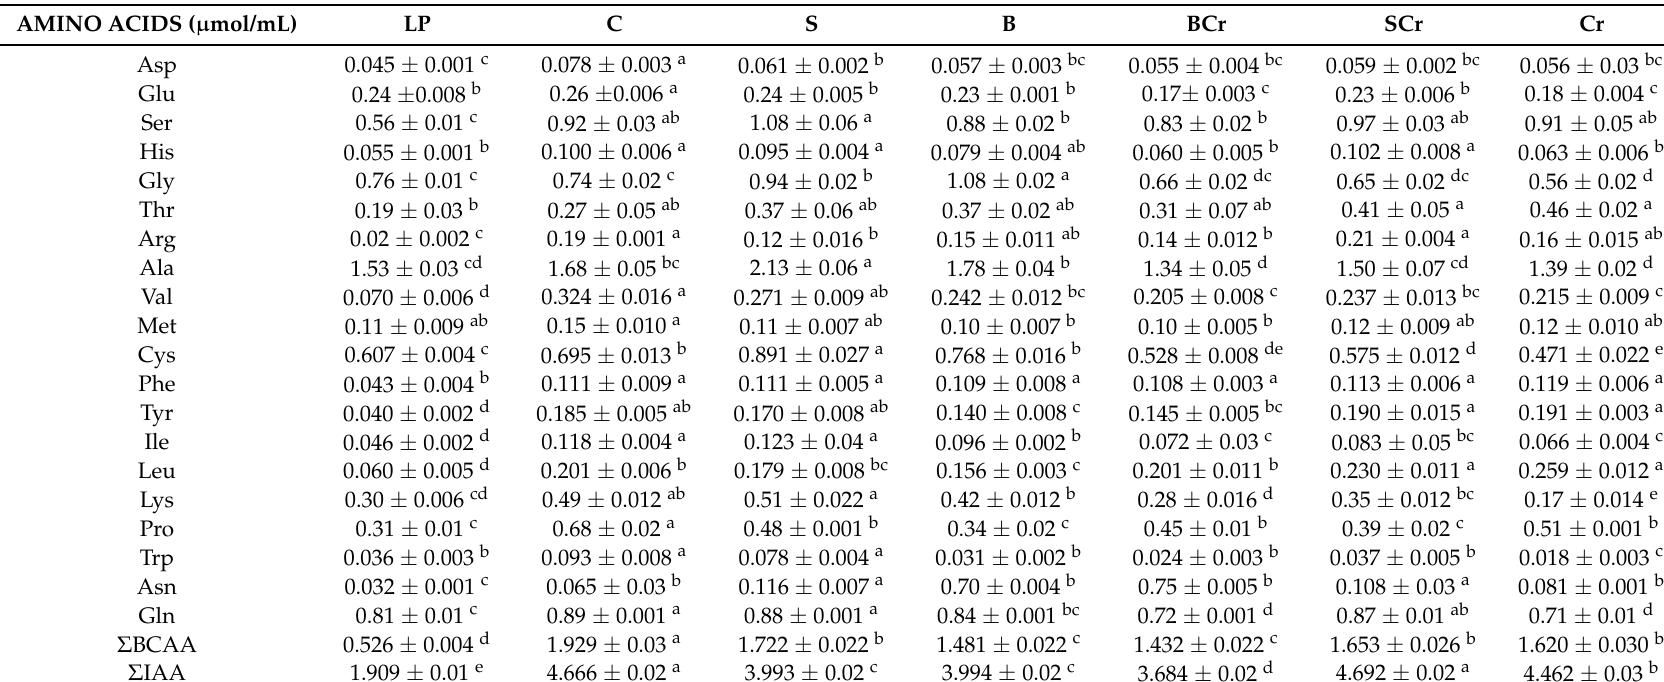
Table 4. Plasma amino acid concentration ( µ mol/mL) of Sprague-Dawley rats fed different types of protein after a protein restricted period. AMINO ACIDS ( µ